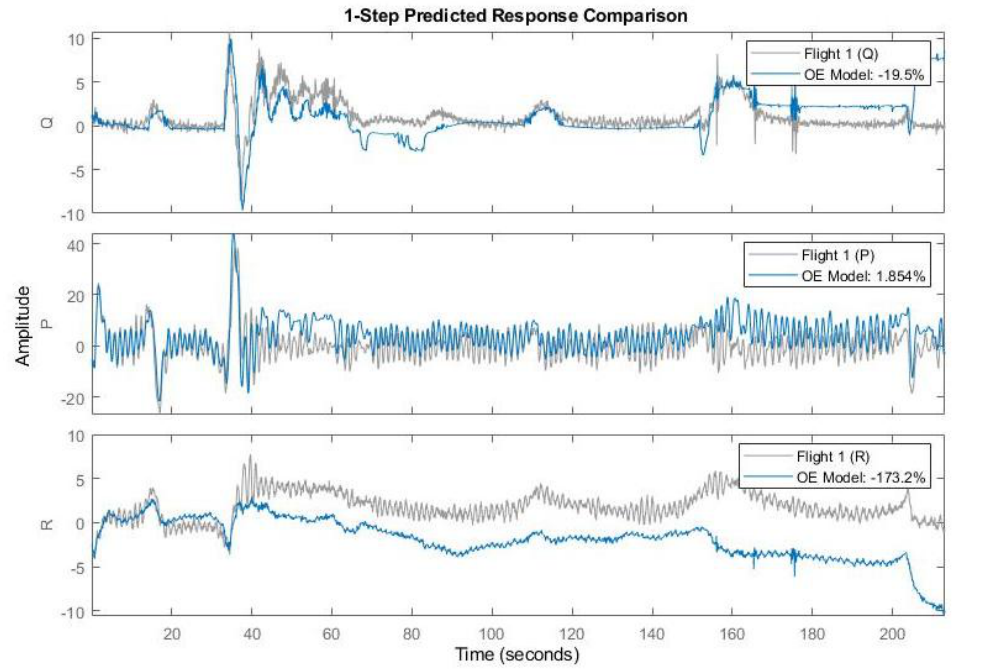
Figure 16. OE Model